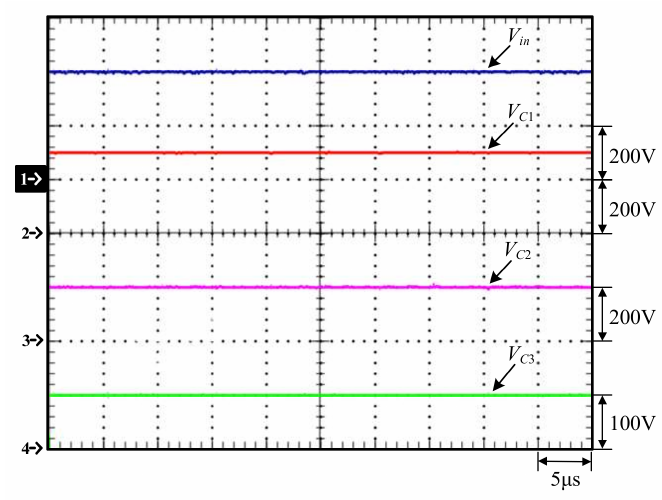
Figure 25. Measured waveforms relevant to 25% of the rated load: (1) V in ; (2) V C 1 ; (3) V C 2 ; (4) V C 3 .